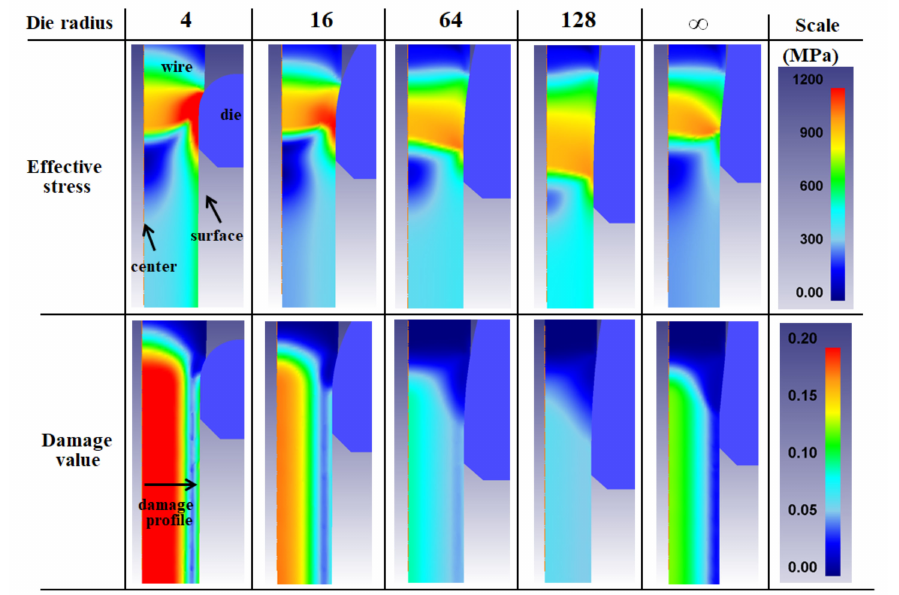
Figure 8. Comparison of contour in effective stress and damage value of the wire with the die radius.